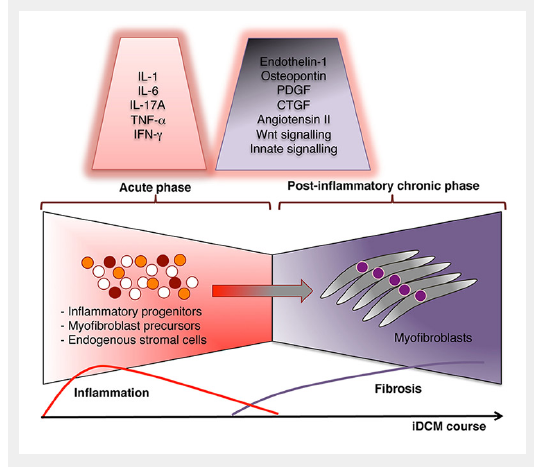
Factors mediating myocardial fibrosis formation in inflammatory dilated cardiomyopathy (iDCM). Active heart inflammation (myocarditis) is characterised by the massive infiltration of mononuclear cells, including monocytes/ macrophages, granulocytes, T cells, dendritic cells, mast cells and cell progenitors. The inflammation slowly resolves and is replaced by fibrotic tissue. Postinflammatory tissue remodelling is a direct cause of heart failure in iDCM. Signalling orchestra modulates the transition from active myocarditis to iDCM. Tissue remodelling is associated with disruption of the highly organised myocardial extracellular matrix and excessive accumulation of collagen and collagen-producing myofibroblasts that leads to heart dysfunction. Mainly inflammatory progenitors and, to some extent, endogenous stromal cells or circulating myofibroblast precursors represent the cellular sources of myocardial myofibroblasts. The most potent factors mediating this specific transition from active myocarditis into iDCM are listed. CTGF = connective tissue growth factor; IFN = interferon; IL =